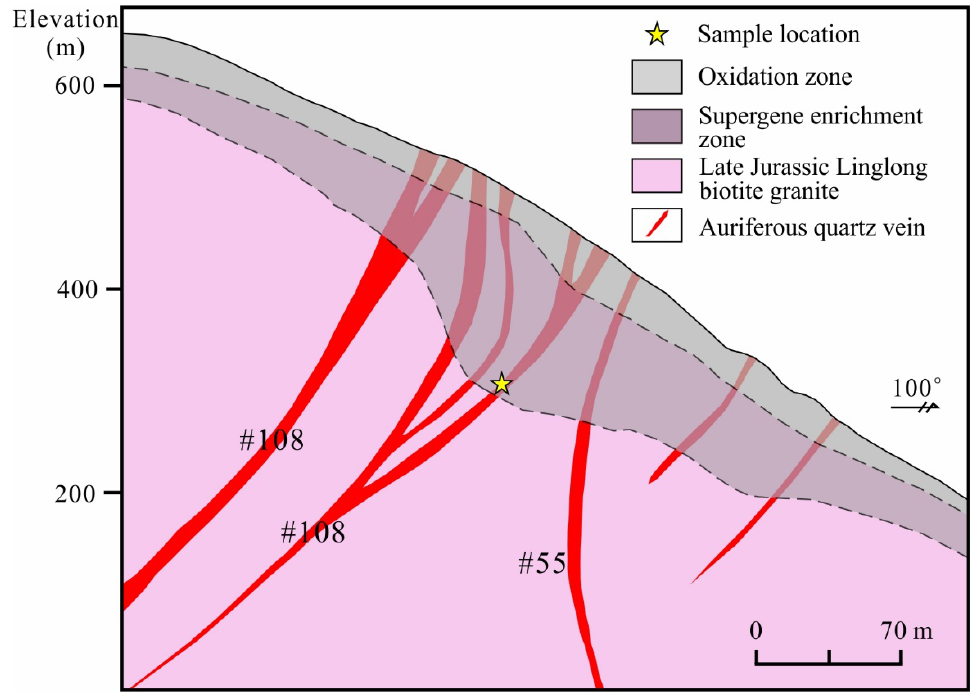
Figure 2. The geological profile along prospecting line #32 in the Xishan mining area (modified after [17]).